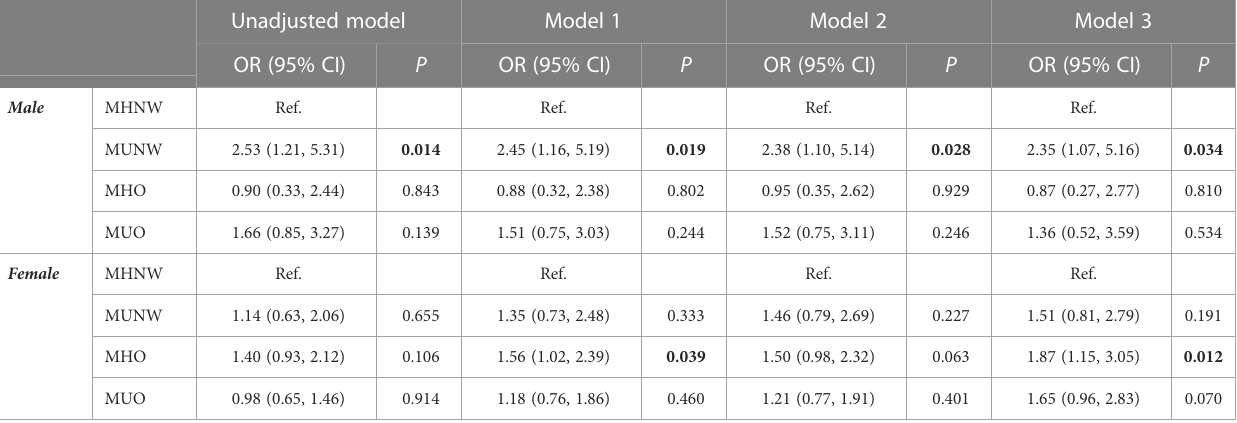
Model 1: adjusted for age. Model 2: adjusted for age and TPO-Ab. Model 3: adjusted for age, TPO-Ab, waist circumference, Cr, smoking, and physical activity. MHNW, metabolically healthy normal weight; MHO, metabolically healthy overweight/obese; MUNW, metabolically unhealthy normal weight; MUO, metabolically unhealthy overweight/obese. Values in bold indicates P <